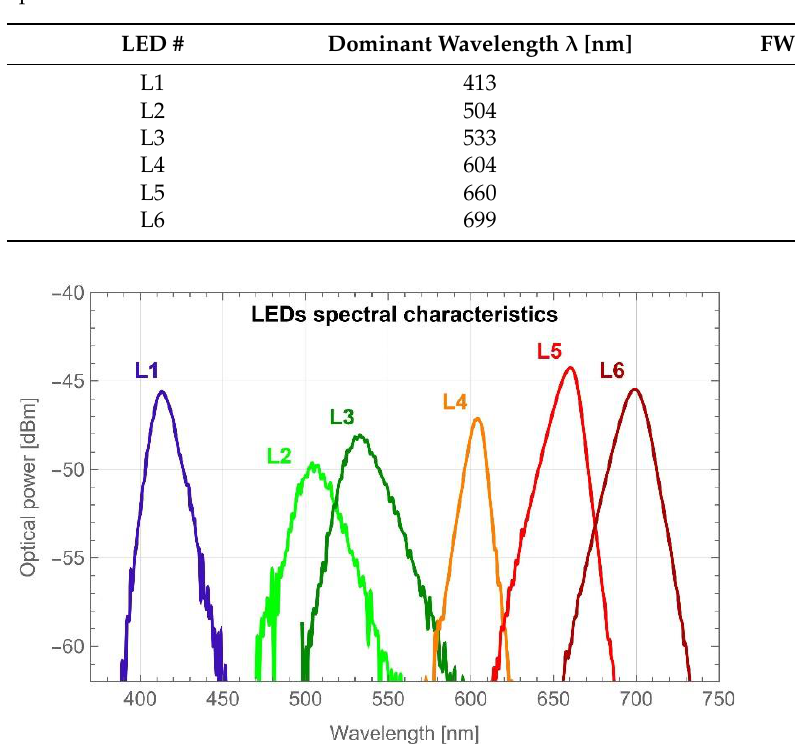
Figure 2. Measured spectral characteristics of all LEDs used in the device.